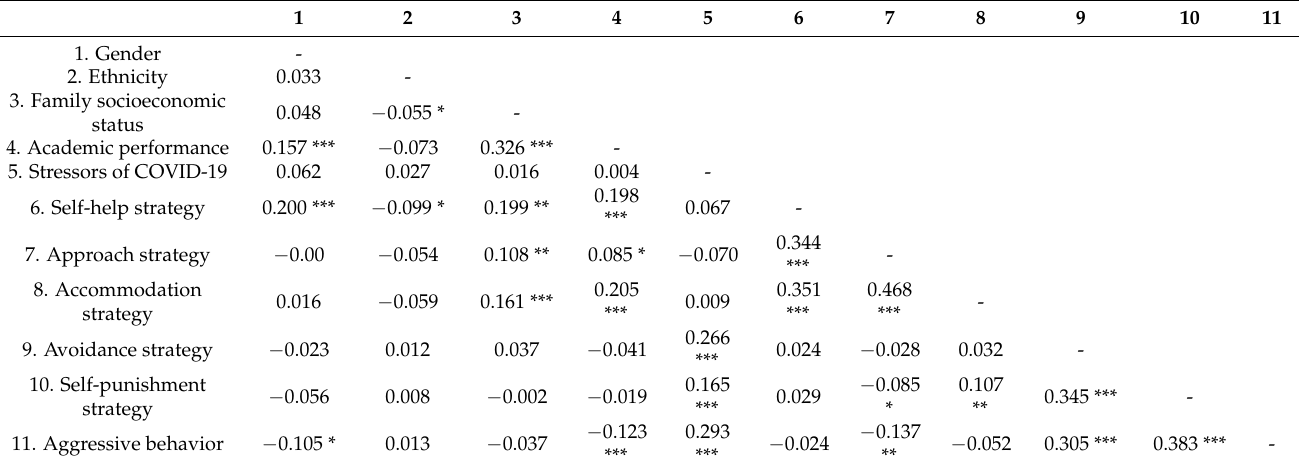
Table 1. Zero-order correlations among the variables in the present study ( n =